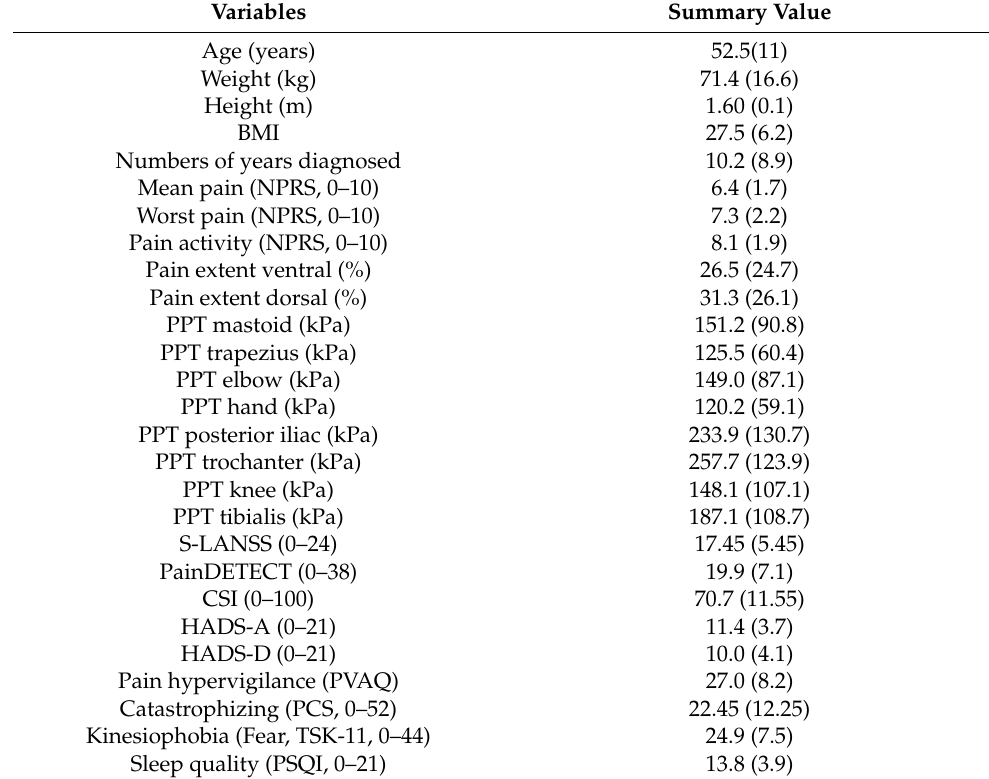
Table 1. Descriptive characteristics of women with fibromyalgia syndrome (FMS, n = 113).